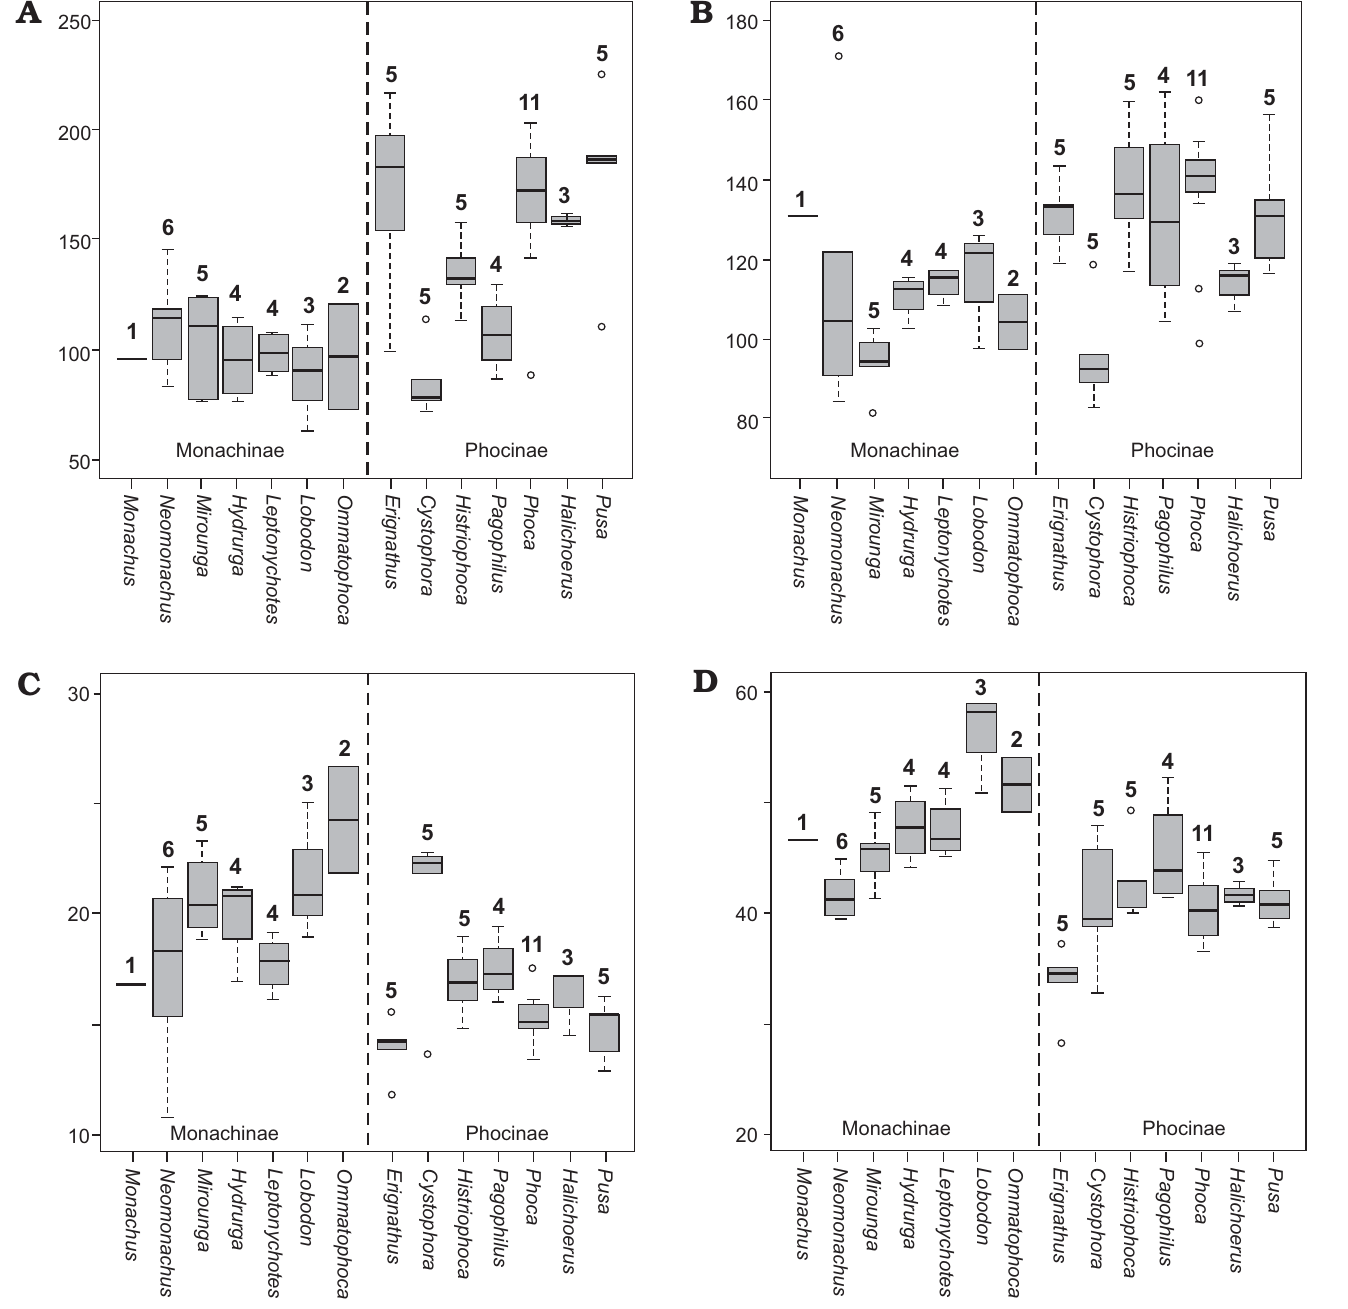
Fig. 5. Boxplots of humeral measurement ratios useful for distinguishing monachine from phocine seal taxa: width of deltoid crest ( A ), trochlea ( B ), proxi- mal end of humerus ( D ) as % of diaphysis width, and width of diaphysis as % of humerus length ( C ). Subfamilies separated by dashed line. Measurements that fall outside the range of values represented by the upper and lower quartiles indicated by circles. Sample size for each genus listed above the